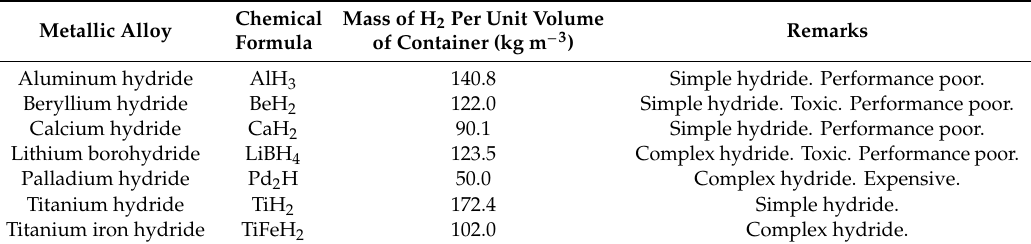
Table 2. Mass of H 2 per volume of container, adapted from